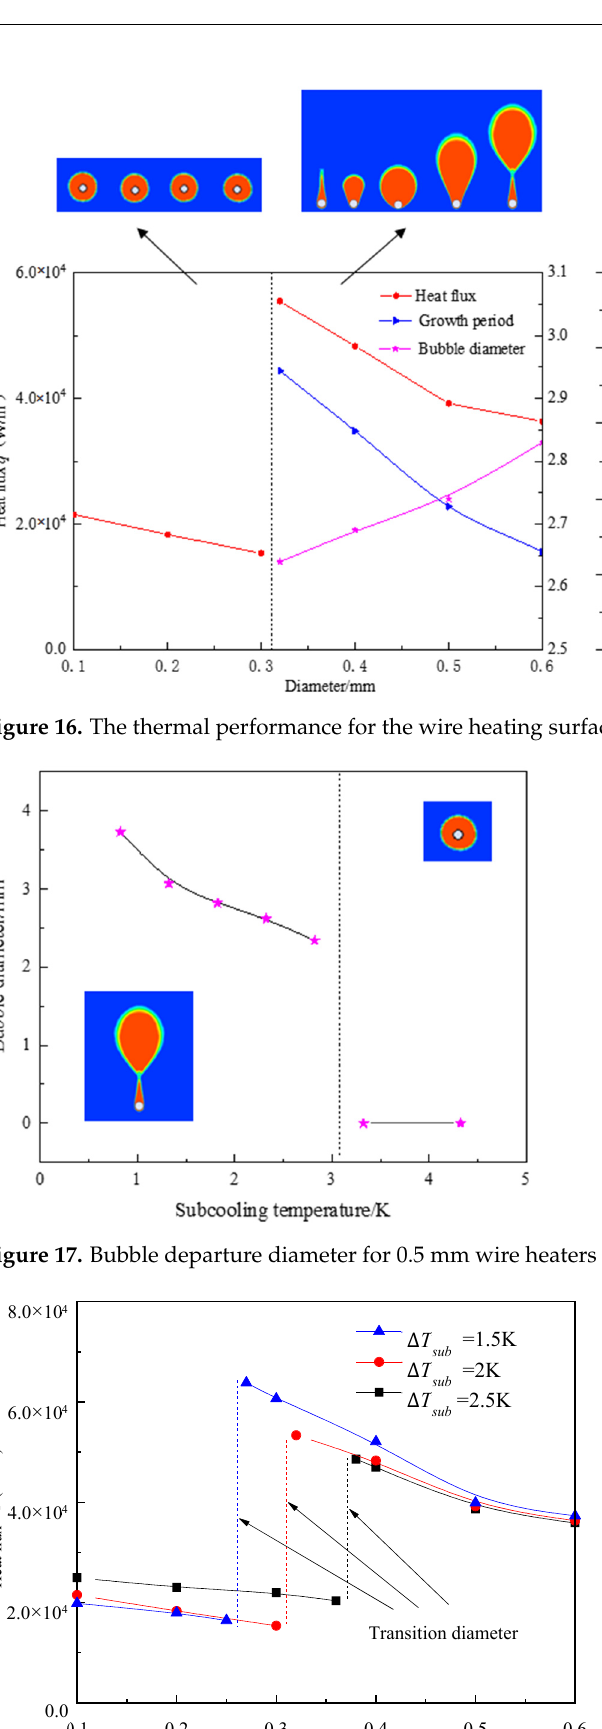
Figure 18. The time-averaged heat flux for a wire with different subcooling degrees.